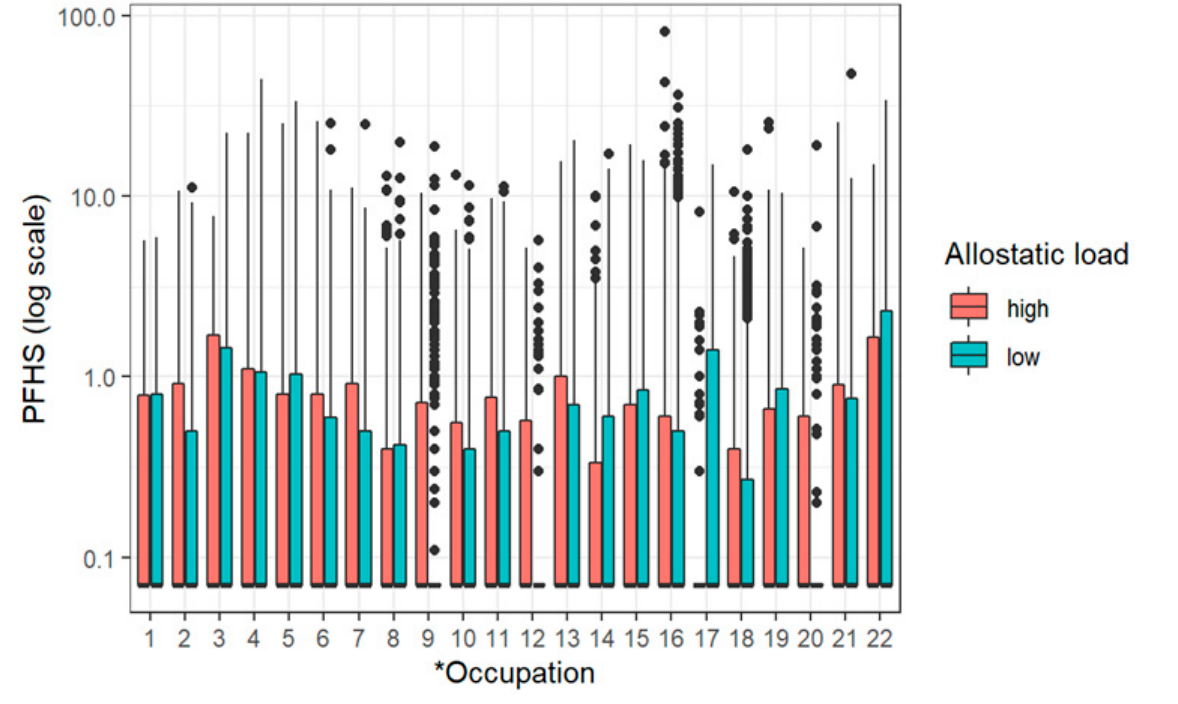
Figure 2. Boxplot showing the interaction between PFHS, occupation, and AL. *Occupation numbers are: 1 Agriculture, Forestry, Fishing, 2 Mining, 3 Utilities, 4 Construction, 5 Manufacturing: